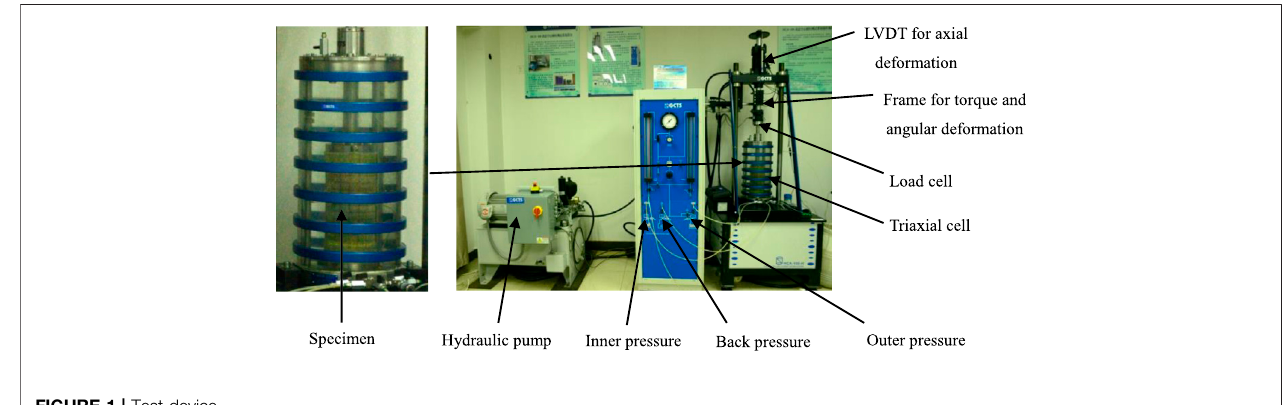
FIGURE 1 | Test device